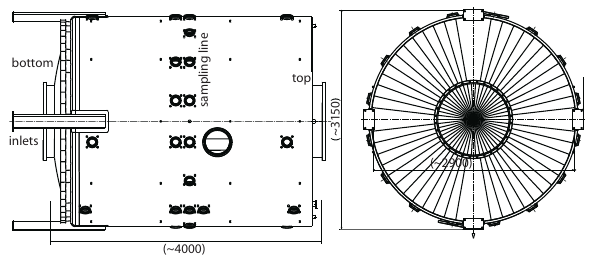
Fig. 2. (a) Numerical grid used for the CLOUD-FPM simulations. The grid has about 20000 grid cells and was generated according to the requirements of the turbulence model applied for the simula- tions. The thin lines next to the bottom and the top are representing the mixing fans and the small, not meshed areas in between are the fan hubs. The mixing fan layer is also shown in detail in (b)